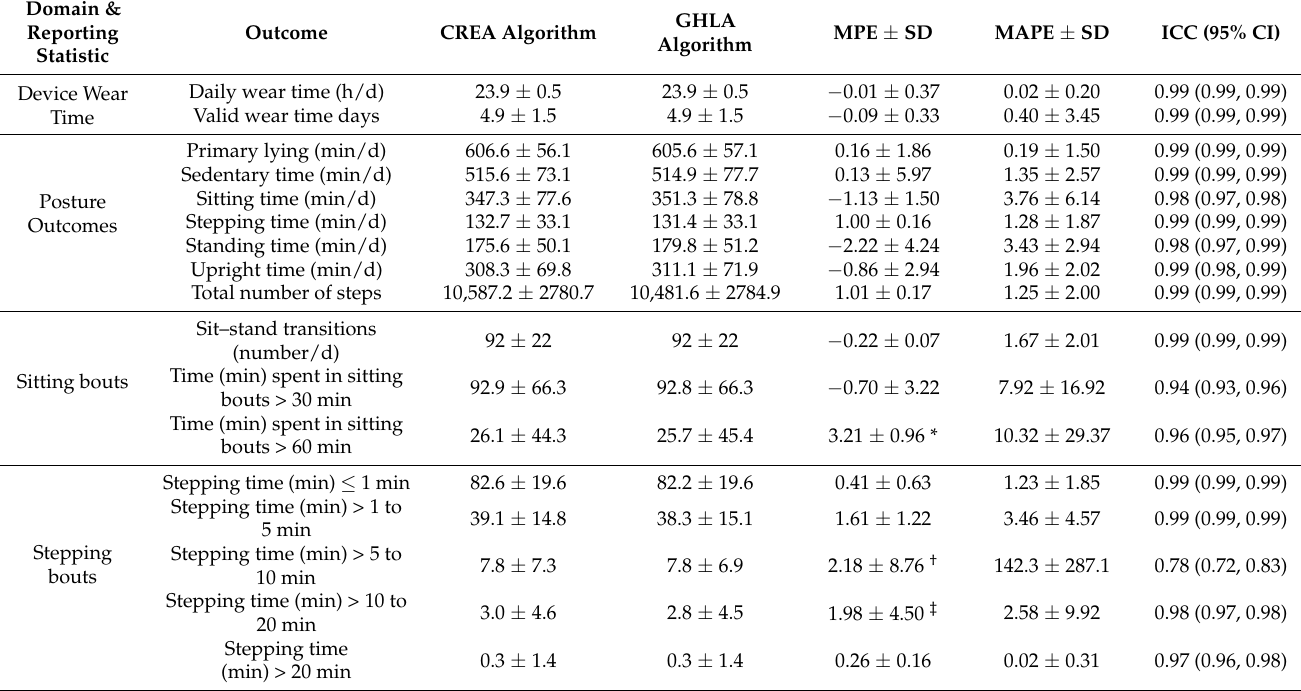
Table 1. Comparison of outcomes provided from the CREA and GHLA algorithms.